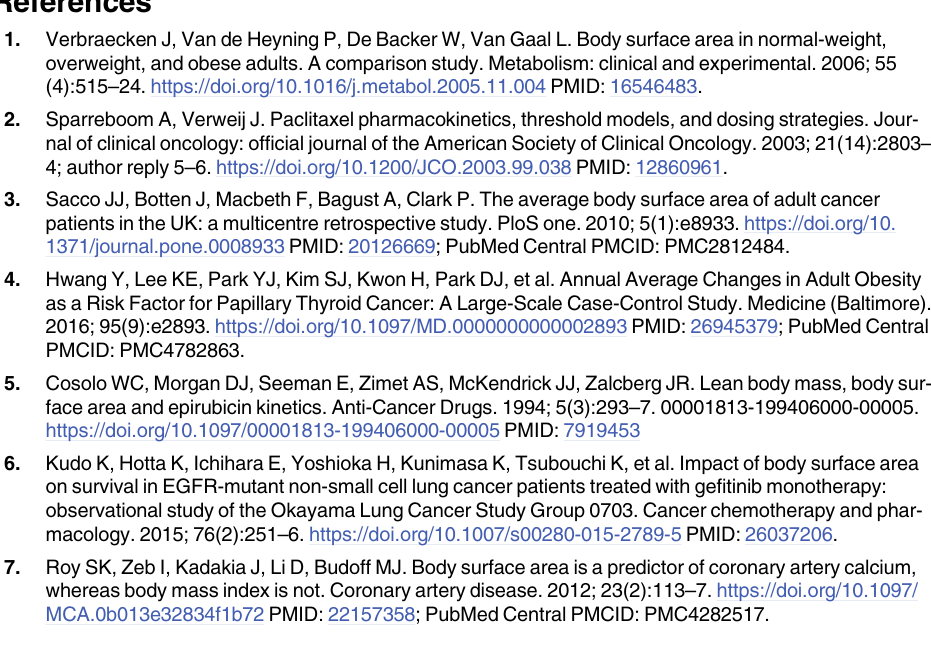
S9 Table. Ethnic-specific risk of cancer diseases. Information retrieved from: https://www. mdanderson.org/publications/cancerwise/race-and-ethnicity-as-cancer-risk-factors.h00-